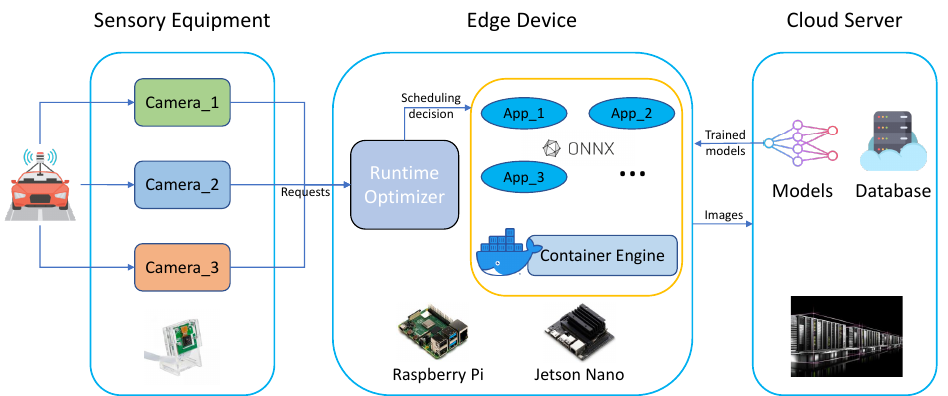
Figure 7. The edge computing architecture of the multi-model-based object detection system for autonomous driving.